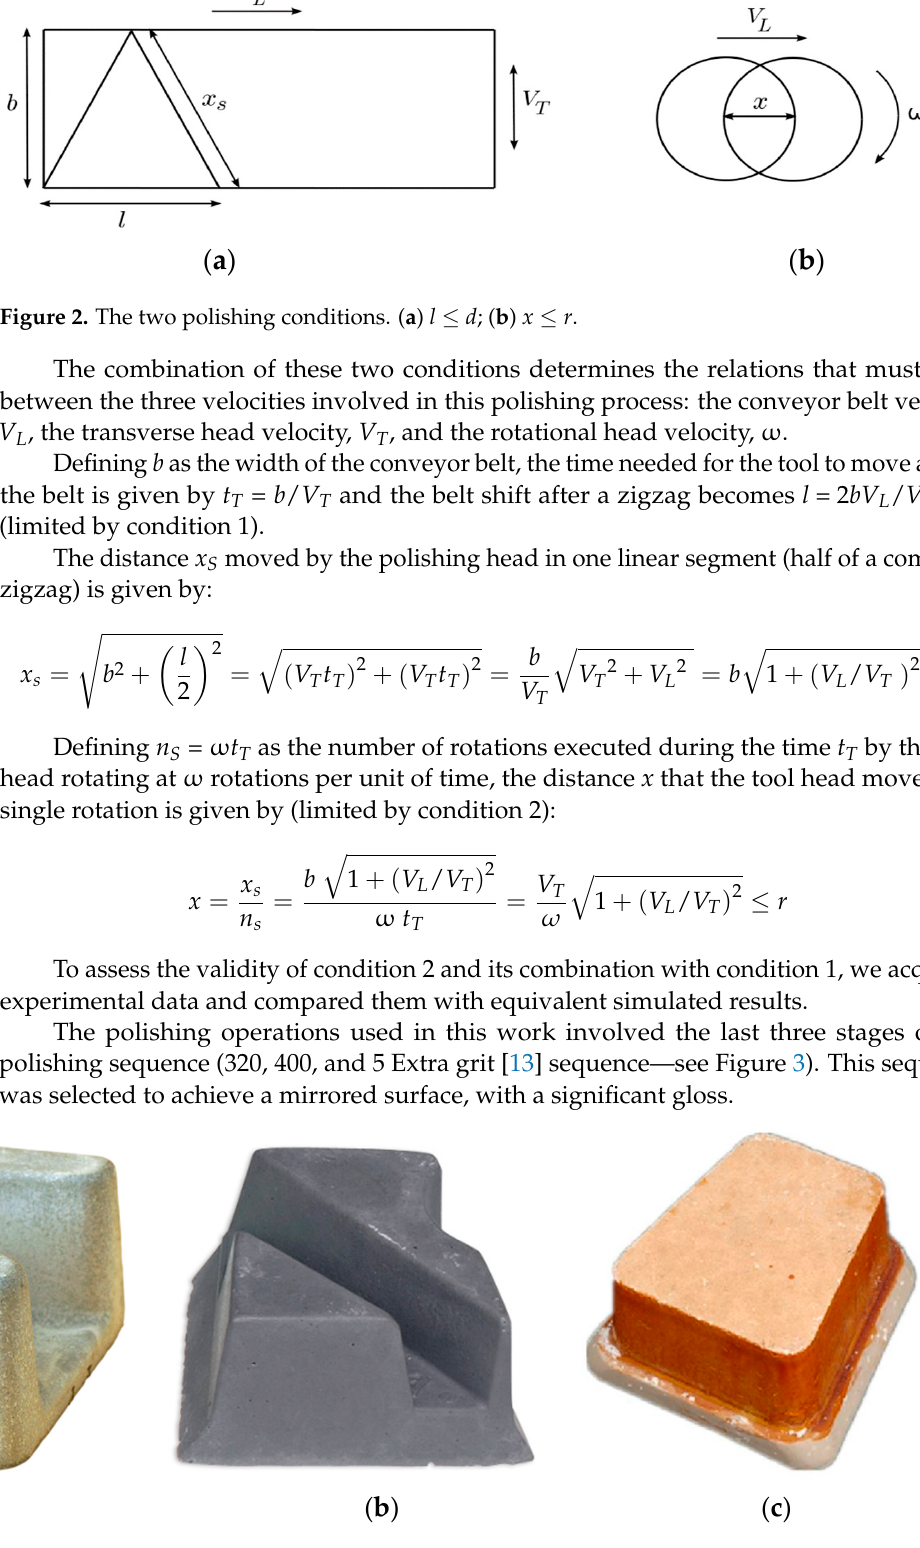
Figure 3. Sequence of the polishing cycle abrasives used in this work: ( a ) 320 grit; ( b ) 400 grit; ( c ) Frankfurt 5 Extra grit.